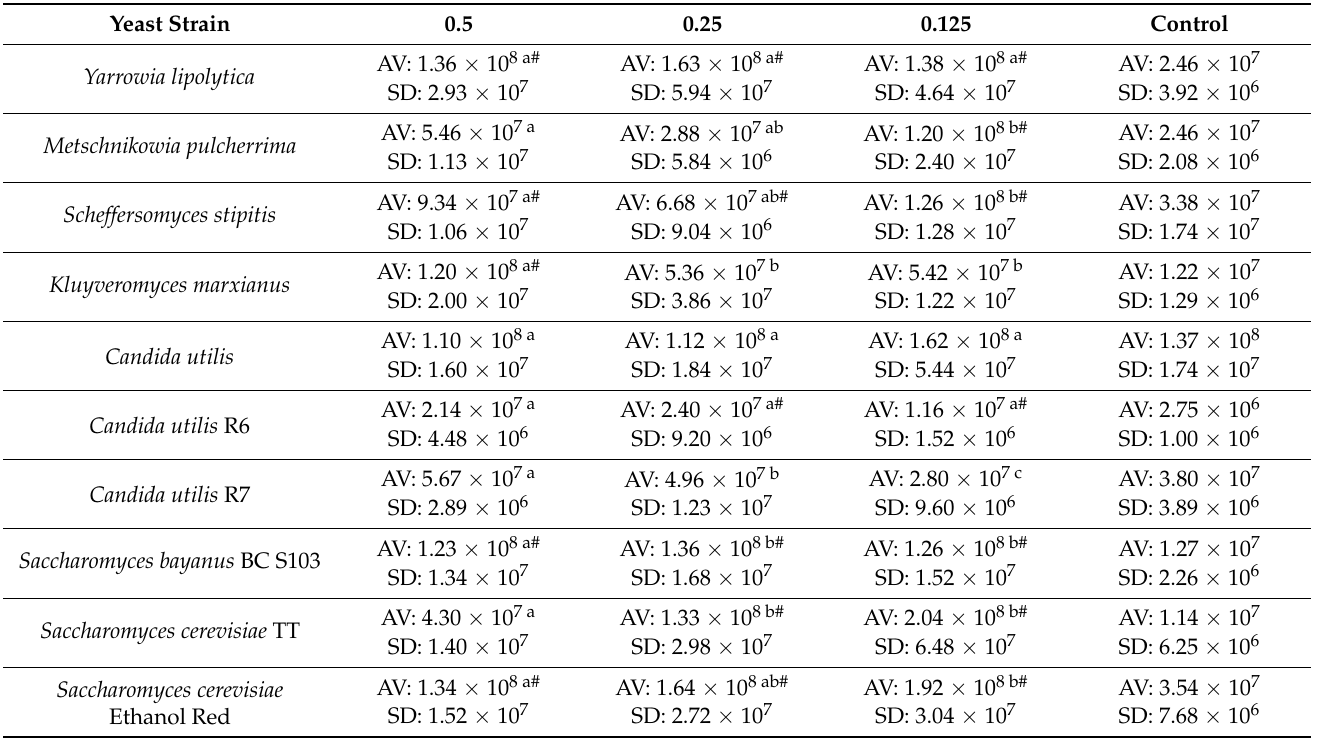
Table 3. Yeast growth [CFU/mL] in culture medium with dried sugar beet pulp pretreated by enzymatic hydrolysis with various enzyme doses D–F [ml/10 g DM]. Yeast Strain 0.5 0.25 0.125